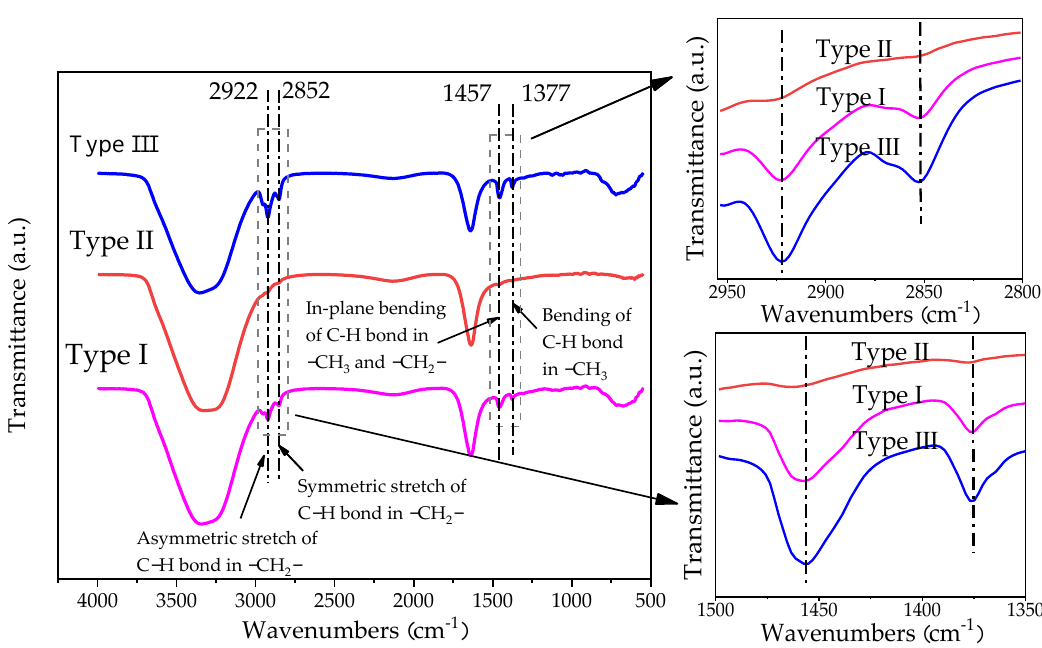
Figure 1. FTIR spectra of the three rejuvenators.